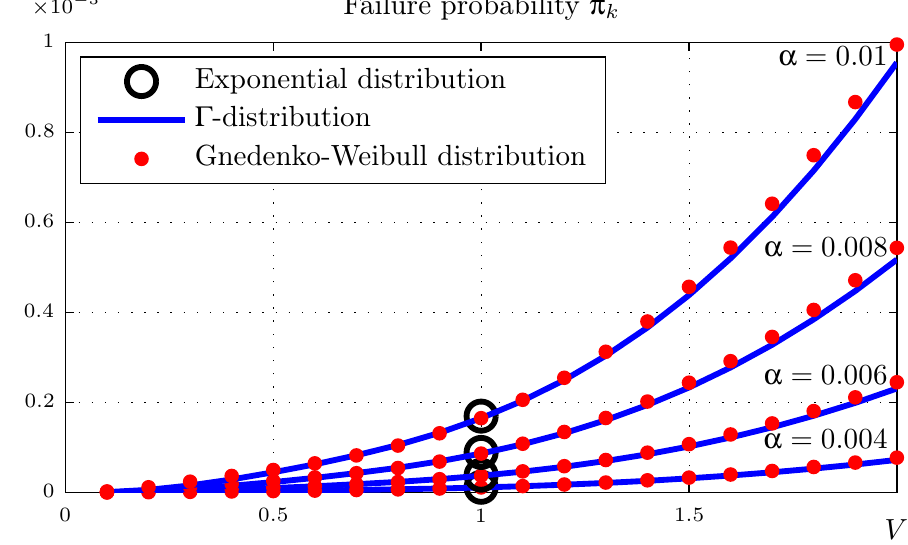
Figure 3. Probabilities of failure of the pipeline sections (“3-out-of-4”) for b = g = 2 years.